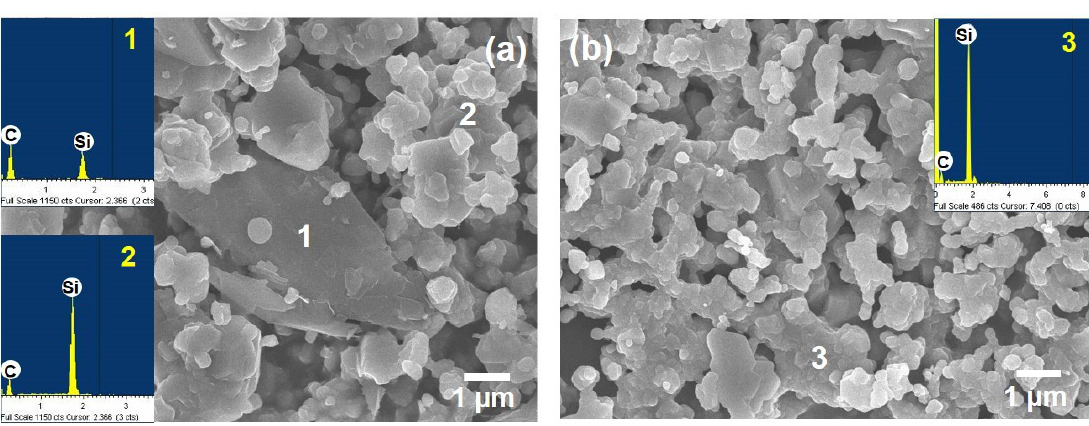
( a ): top, EDS spectra at point 1; bottom, EDS spectra at point 2; inset of ( b ): EDS spectra at point 3.